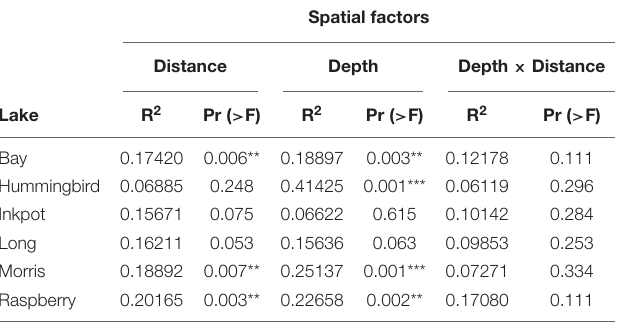
TABLE 4 | Spatial effects by PERMANOVA within individual lakes.